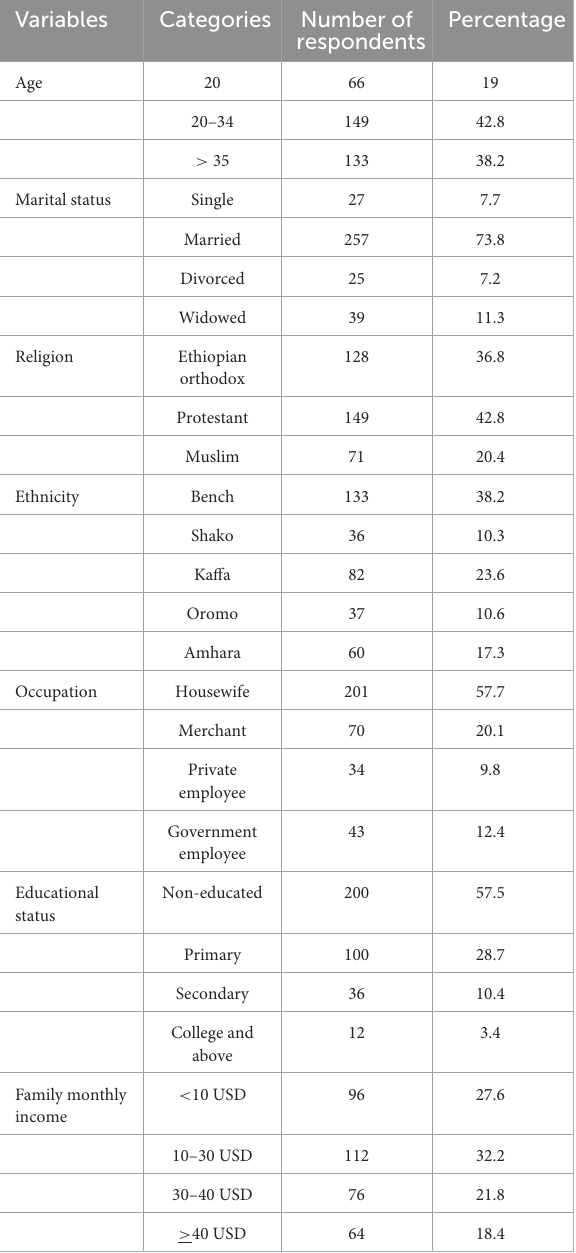
TABLE 1 The socioeconomic characteristics of mothers at three public hospitals in Southwest Ethiopia in 2021 ( n = 348).